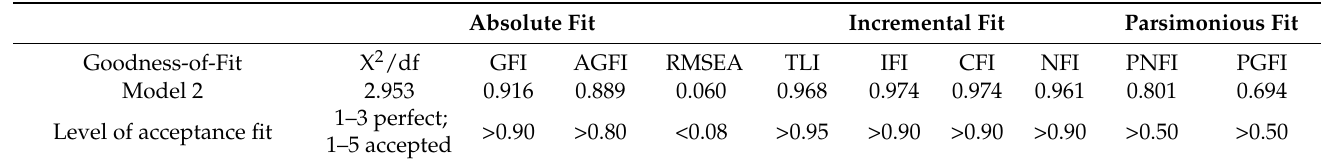
Table 9. Goodness-of-fit of model 2.